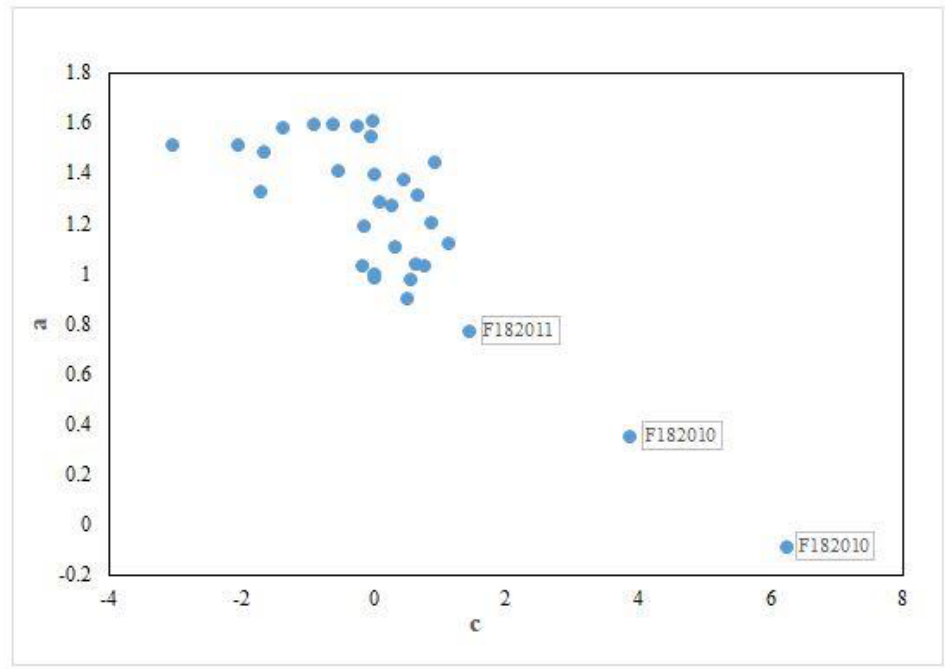
Figure 4. The calibration coefficients of the RSR method with F152000 as the reference image.